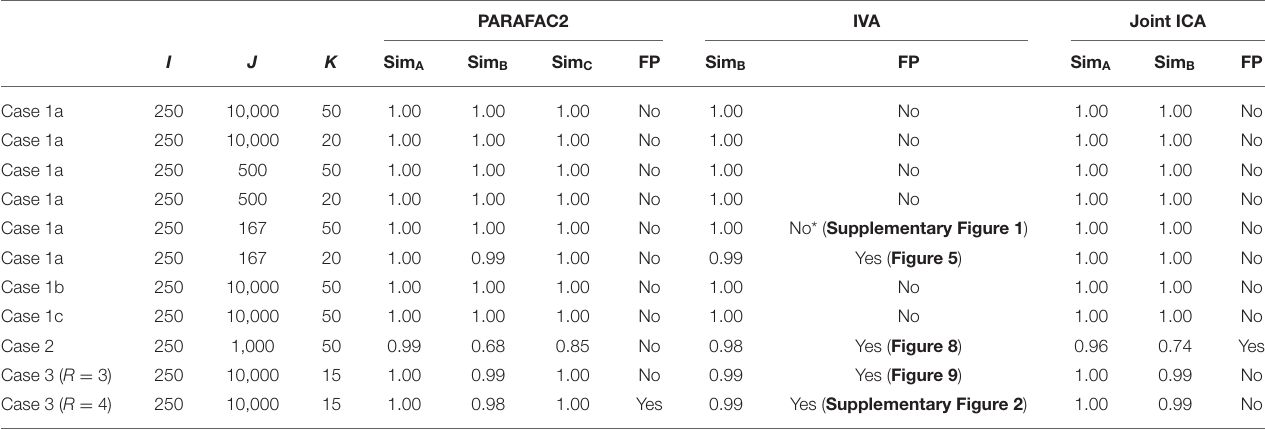
TABLE 1 | For each case, dataset sizes ( I , J , K ), similarity scores (Sim A , Sim B , Sim C ) showing the accuracy of the methods in terms of capturing the underlying patterns in the first (subject), second (network/voxel), and third (time) modes, respectively, and whether methods give false positive (FP) markers, i.e., identifying components that are not indicating group difference as potential markers with statistically significant group